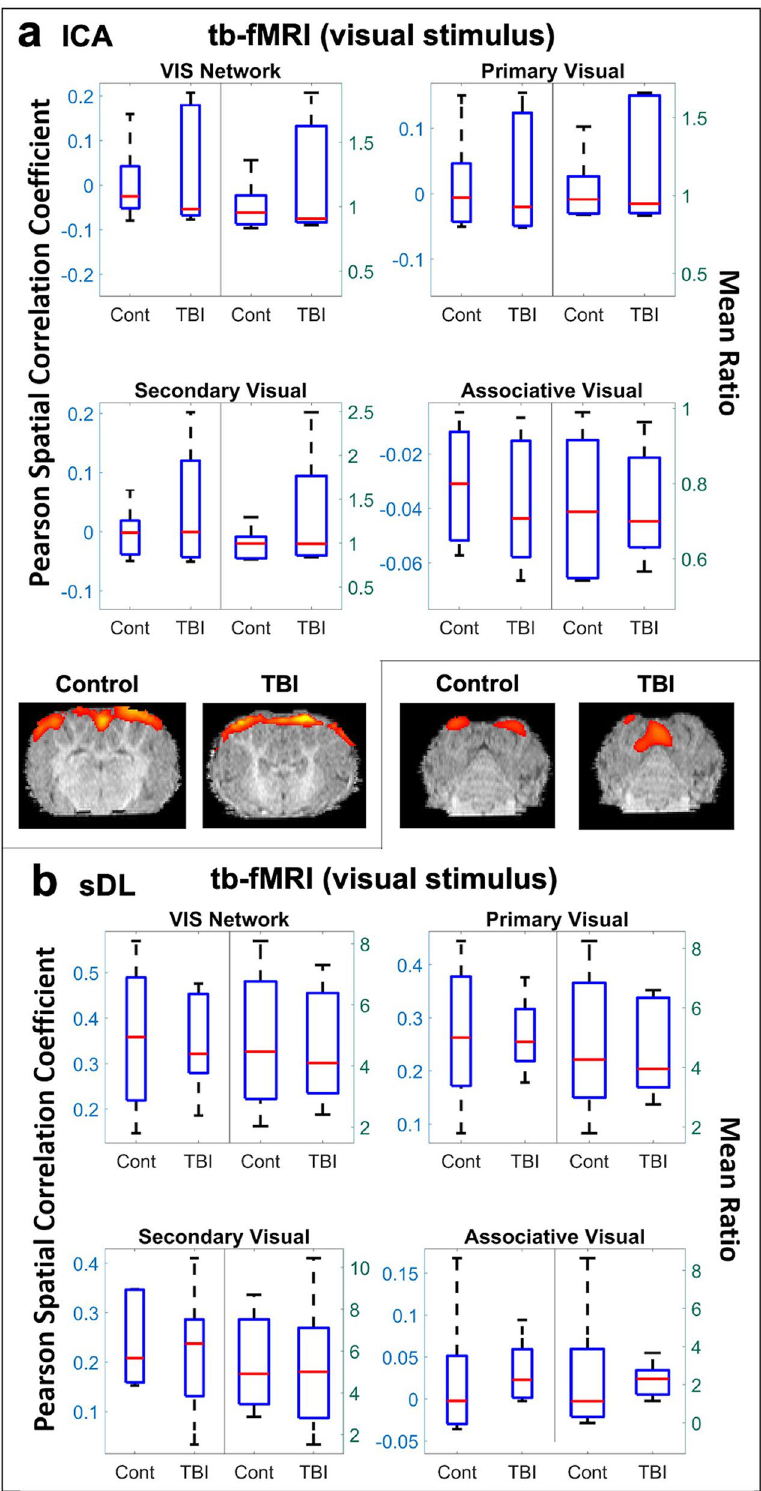
Figure 6. Task-based (tb-) visual stimulus analysis of the visual (VIS) network. Boxplots of Pearson spatial correlation coefficients (left) and mean ratios (right) obtained from the tb- analysis for the VIS network and its individual anatomical regions obtained using independent component analysis (ICA; a ) and sparse dictionary learning (sDL; b ). The red line denotes the median, the blue box denotes the interquartile range, and the lower and upper whiskers denote the min and max, respectively. An asterisk (*) or pound (#) in the upper right-hand corner indicates significant decrease or increase (p < 0.05), respectively, for the TBI group in comparison to the control group. Representative axial plane activation maps overlaid on the template pigs’ T1-weighted anatomical image are also displayed. Representative maps in the coronal and sagittal plane are provided in the Figures S4 and